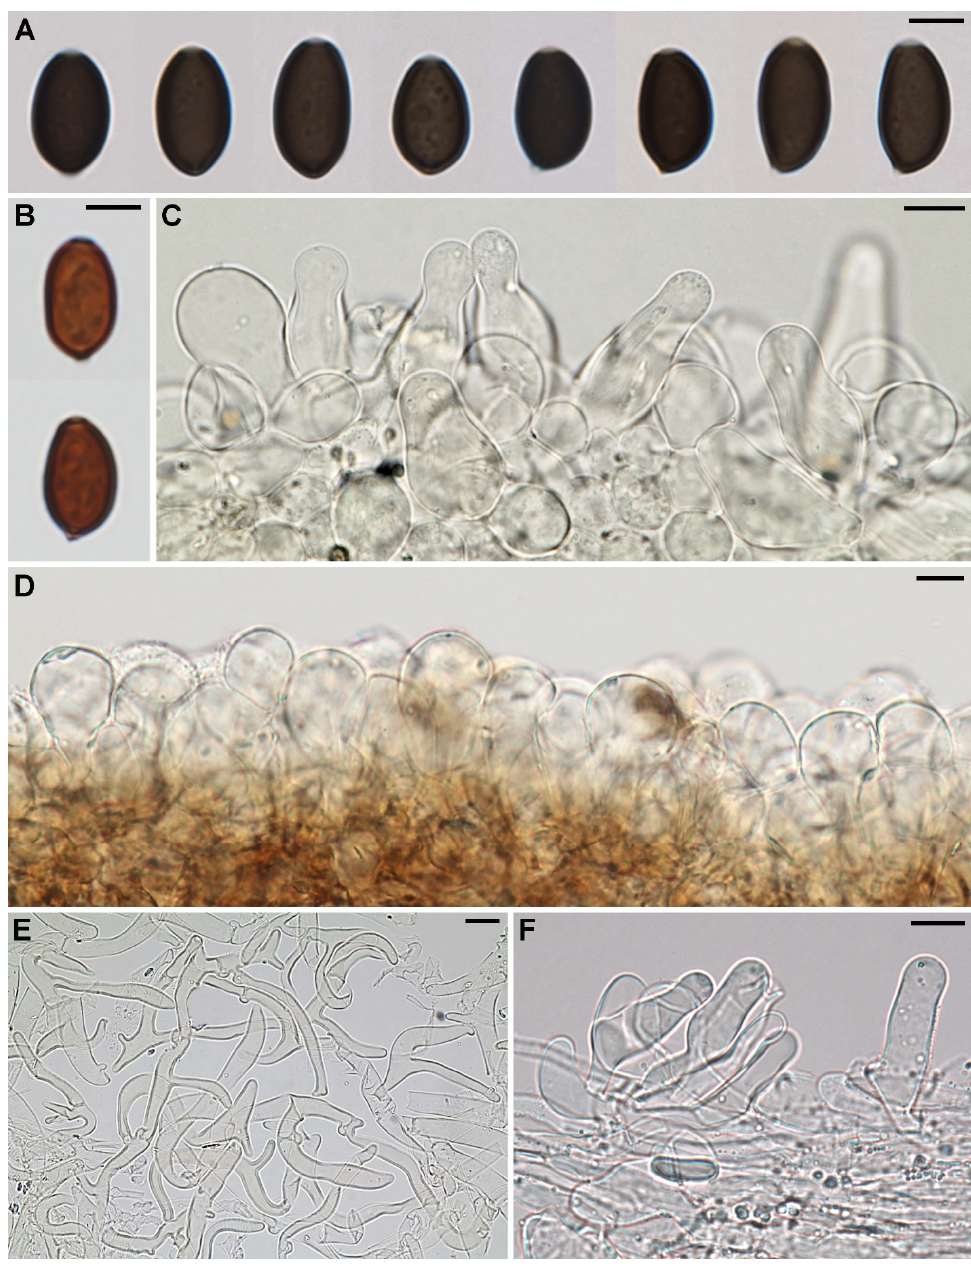
Figure 3. Hausknechtia leucosticta , TBGT13589 & CNF 1/6900. ( A ) Basidiospores in KOH. ( B ) Basidiospores in H 2 O. ( C ) Cheilocystidia . ( D ) Pileipellis . ( E ) Veil on the pileus. ( F ) Caulocystidia . Bars: ( A , B ) = 5 µm, ( C – F ) = 10 µm.